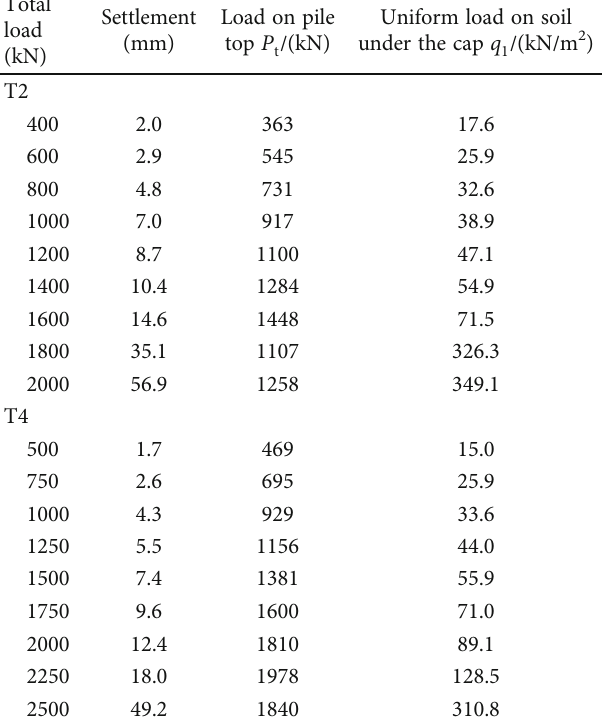
Table 2: Measured data of T2 and